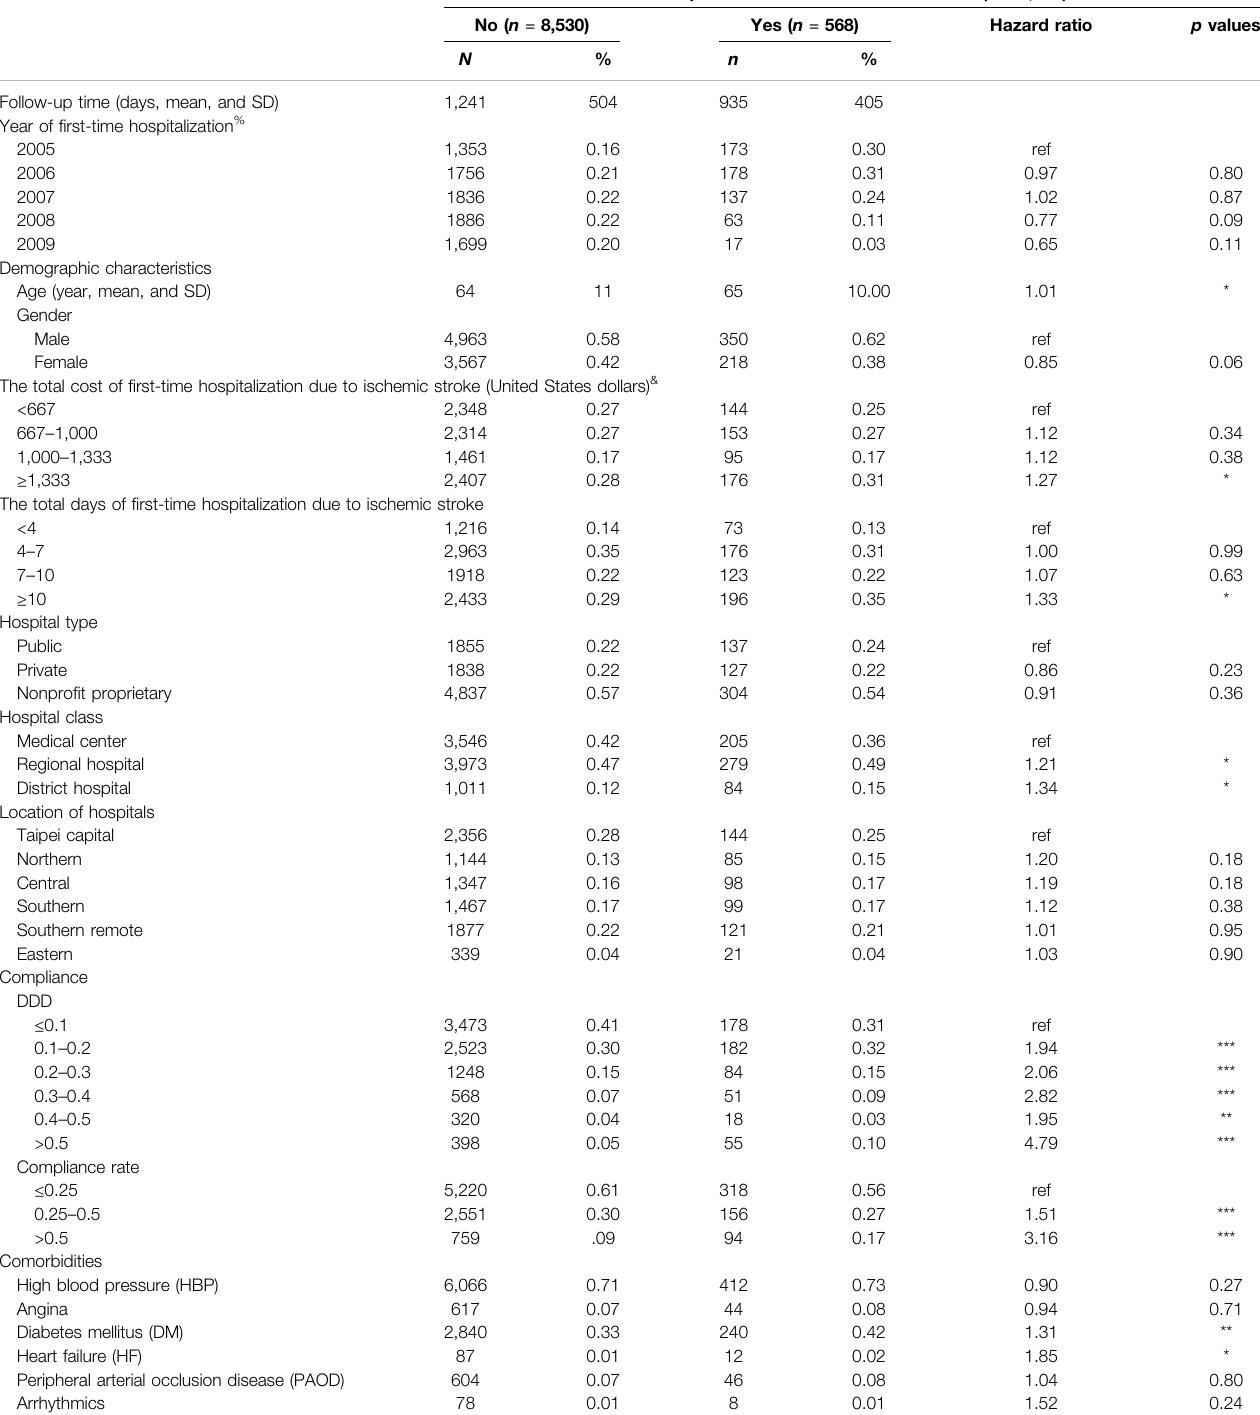
TABLE 1 | Descriptive statistics of study